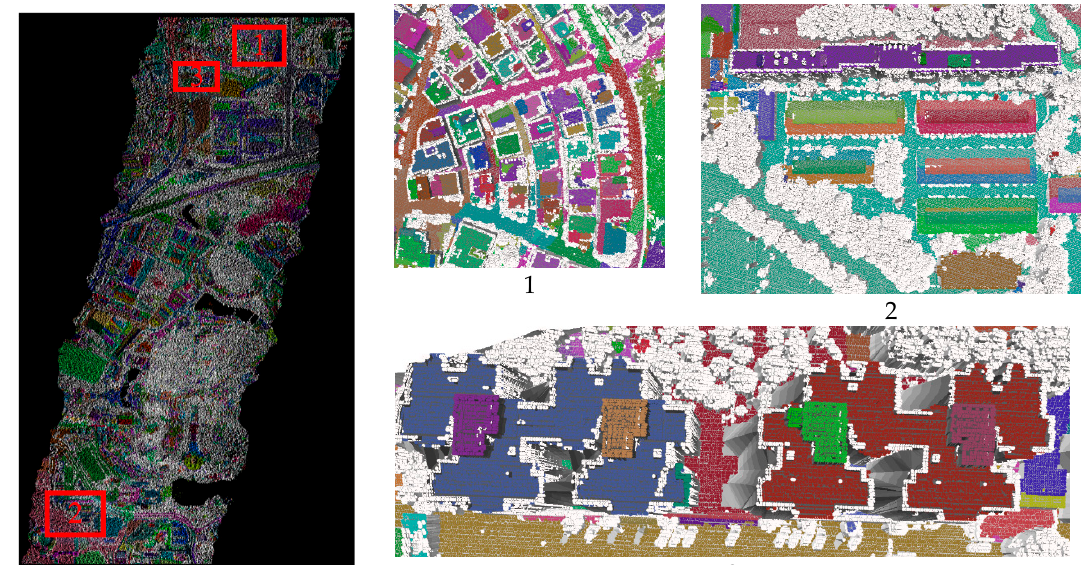
Figure 18. Segmentation results in the Guangzhou area using dataset (g).